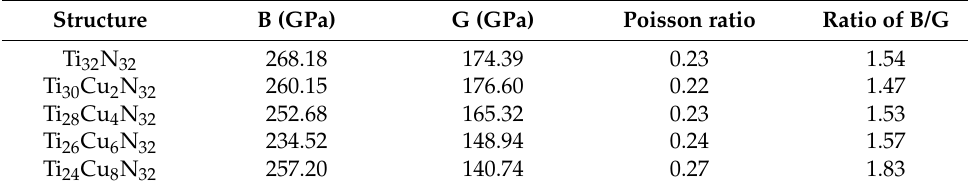
Table 5. Bulk modulus, shear modulus, Poisson’s ratio, and the ratio of B / G for TiCuN with different Cu